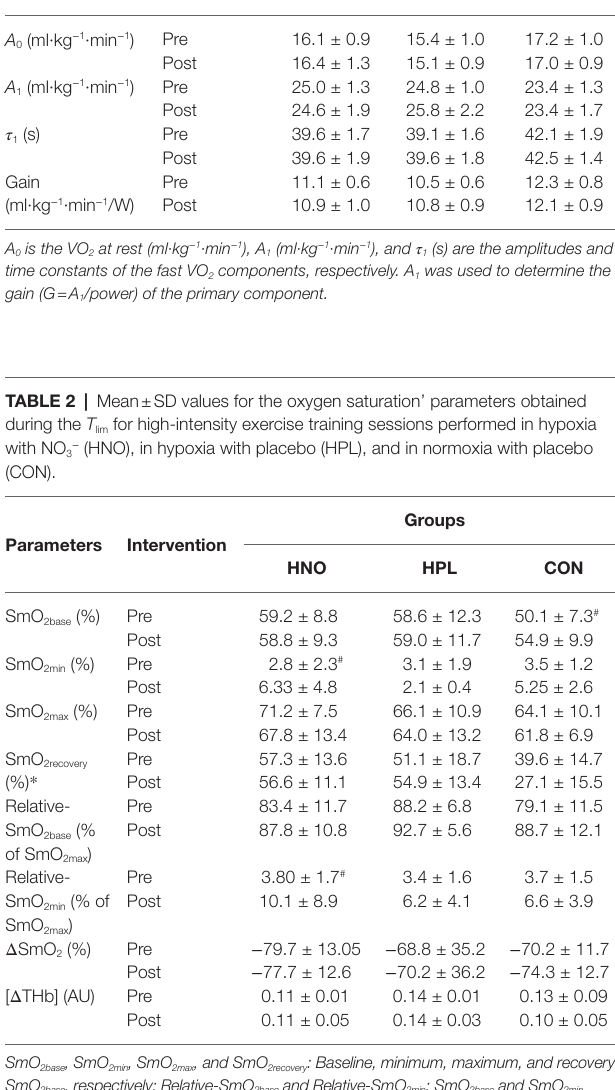
TABLE 1 | Mean ± SD values for the  VO 2 kinetics’ parameters obtained in pre- and post-intervention periods during T lim for high-intensity exercise training sessions performed in hypoxia with NO 3 − (HNO), in hypoxia with placebo (HPL), and in normoxia with placebo (CON). Parameters